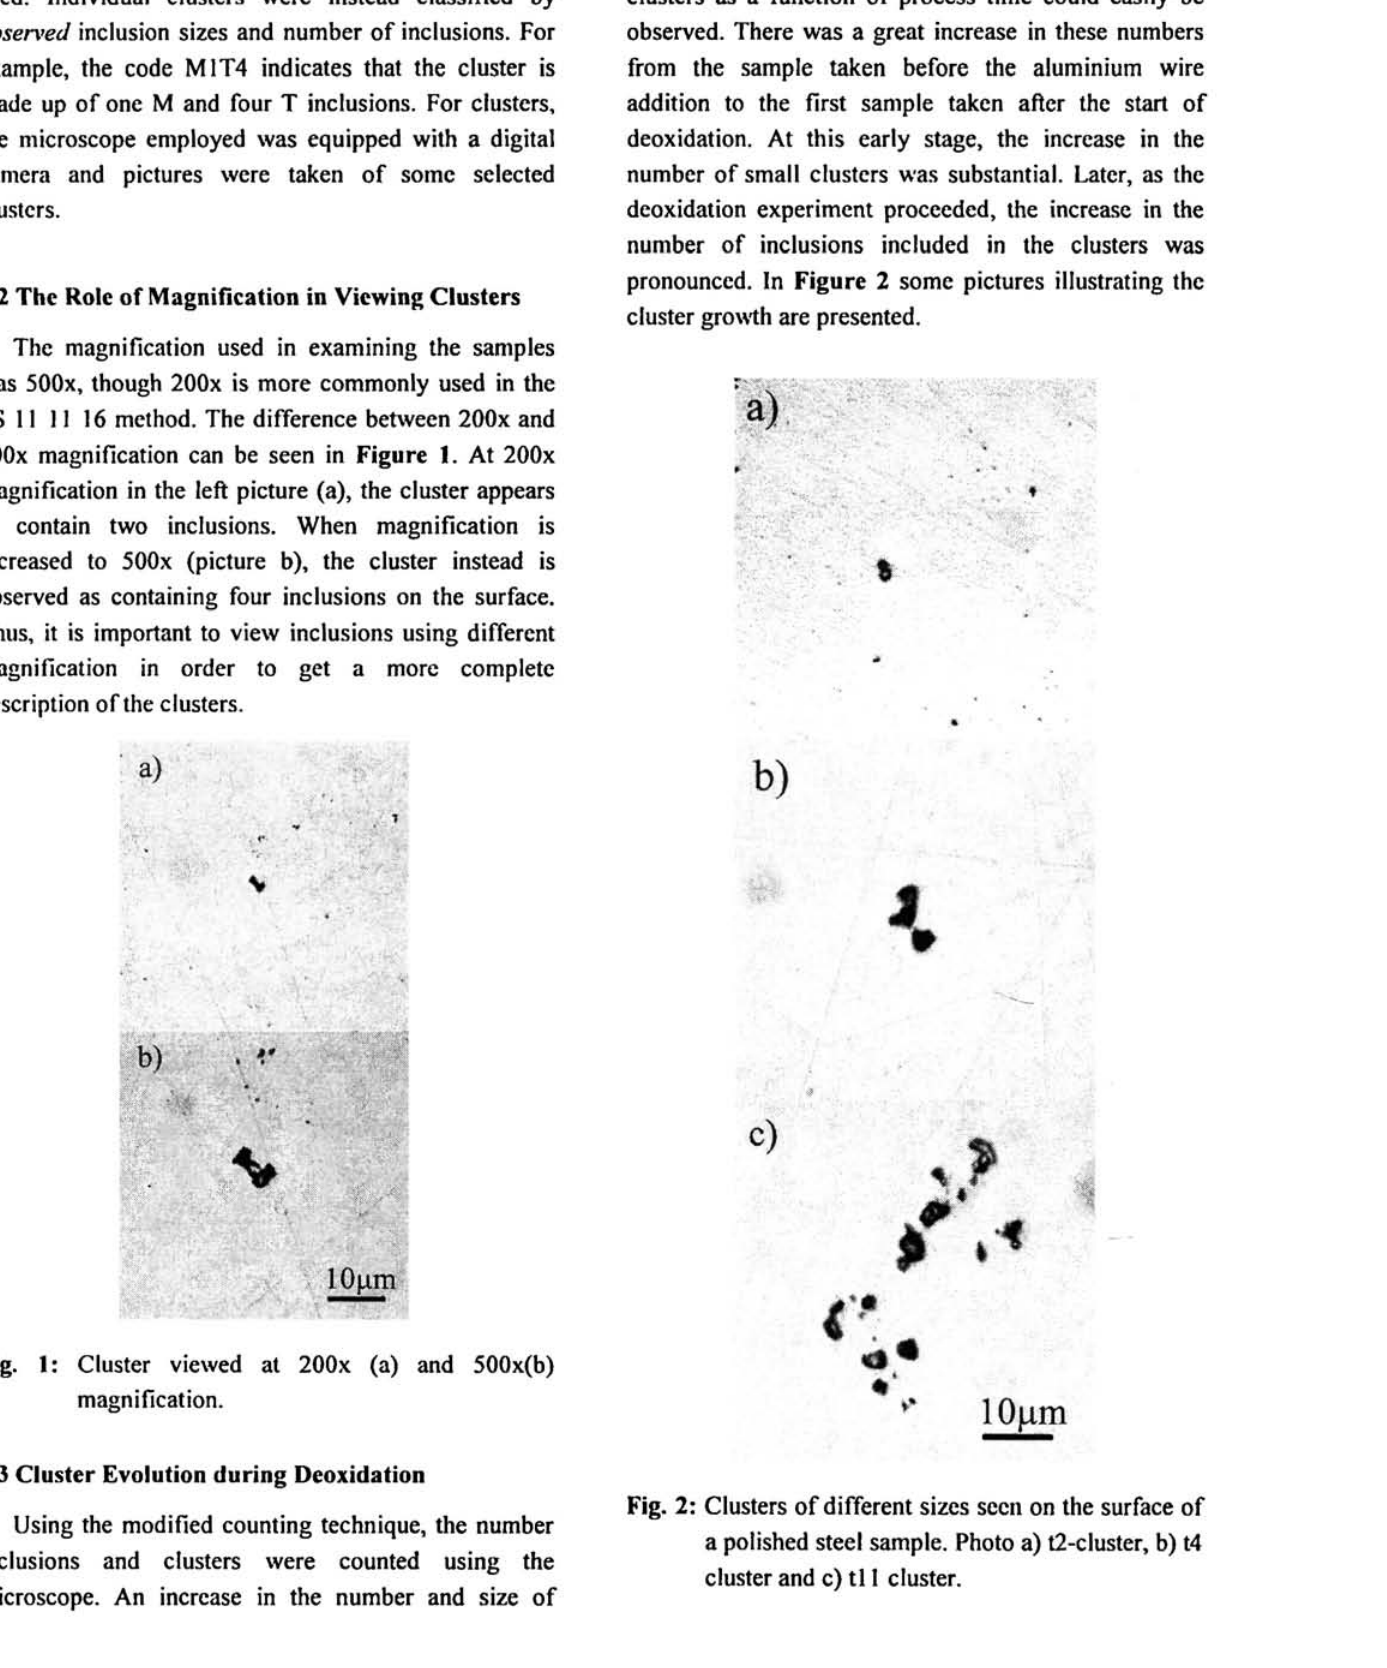
Fig. 2: Clusters of different sizes seen on the surface of a polished steel sample. Photo a) t2-cluster, b) t4 cluster and c) tl 1